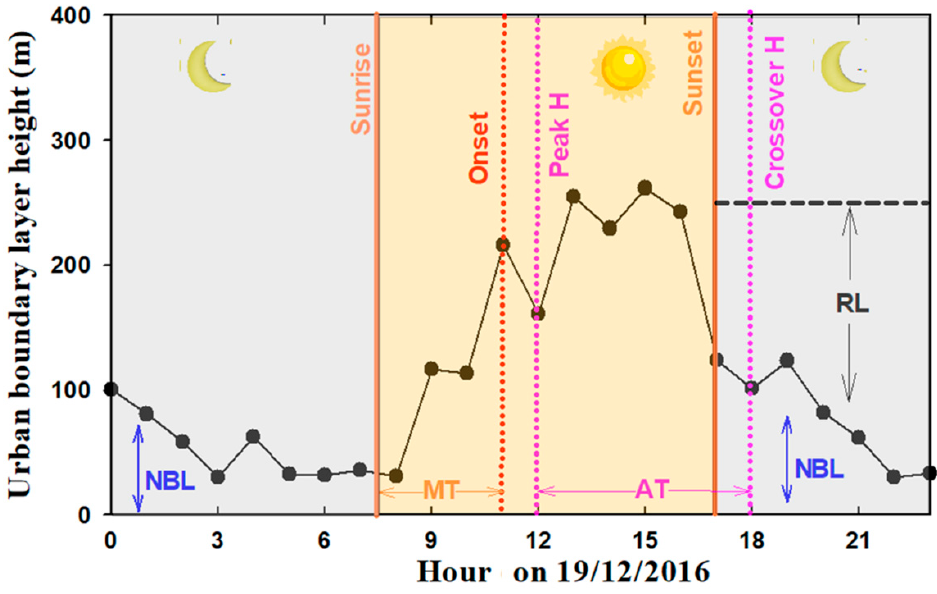
Figure 8. Schematic illustration of the diurnal cycle of the atmospheric boundary layer (ABL) over Beijing on 19 December 2016.